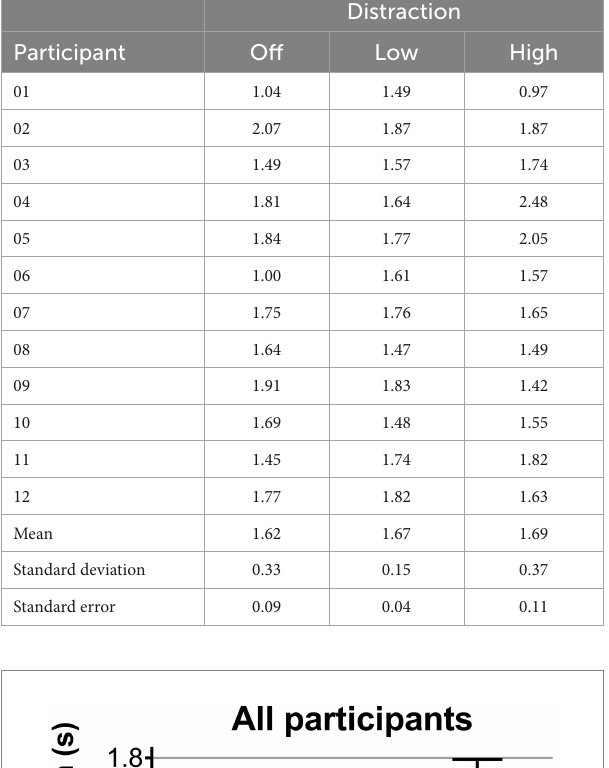
TABLE 3 Mean critical stimulus durations (seconds) for each participant in each distraction condition, together with overall means, standard deviations and standard errors.